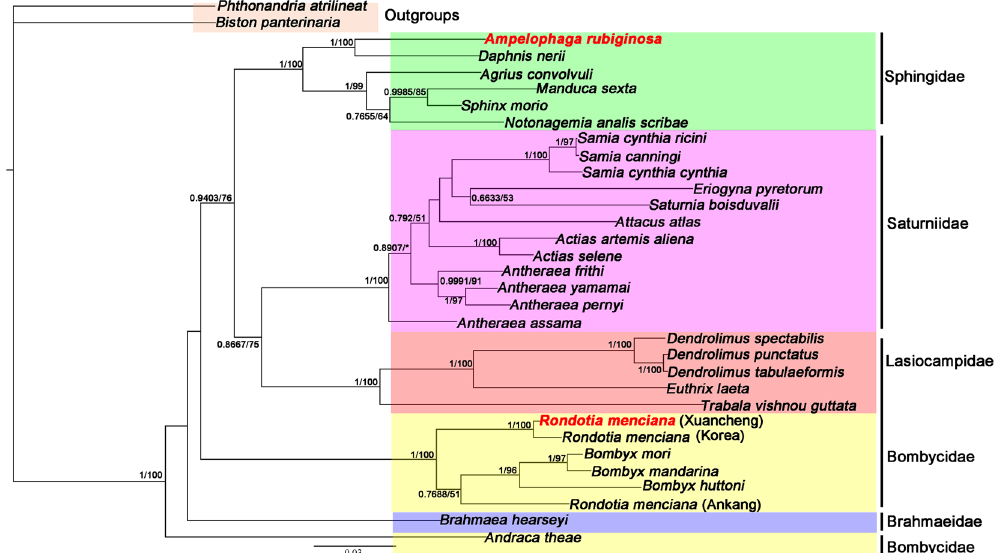
Figure 7. Phylogenetic tree derived for Bombycoidea using BI and ML analyses based on 16S ribosomal RNA and 12S ribosomal RNA sequences of 33 species (there are no 16S ribosomal RNA and 12S ribosomal RNA sequences in the Apatelopteryx phenax (KJ508055)). Bayesian posterior probability (BPP) and bootstrap value (BP) of each node are shown as BPP/BP, with maxima of